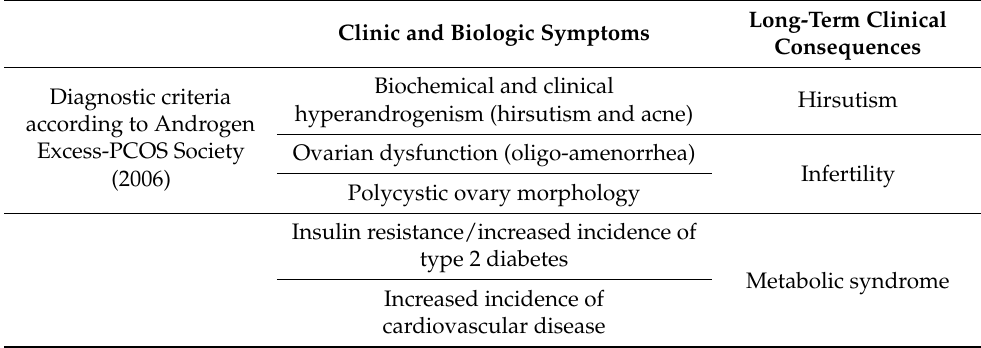
Table 1. Diagnostic criteria according to AE-PCOS Society (2006) and long-term consequences